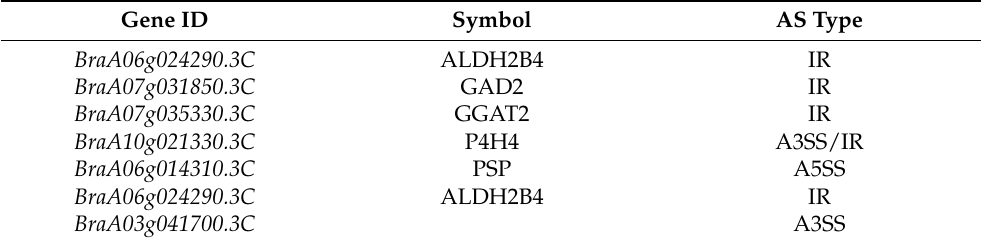
Table 3. Ddifferent AS genes in amino acid metabolism